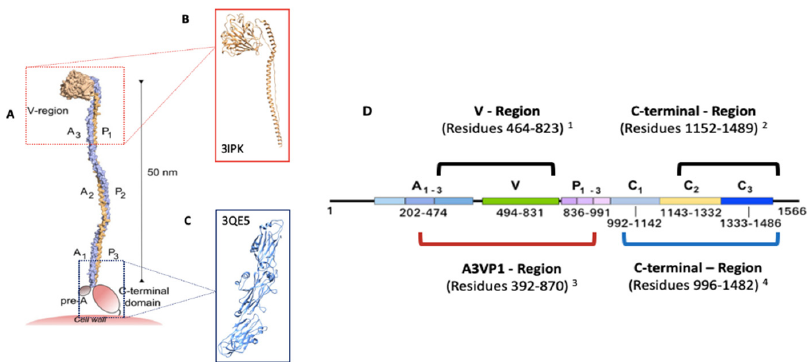
Figure 1. Crystals structures from the S. mutans Ag I/II protein ( A ). Model of S. mutans Ag I/II structure and predicted binding with human SAG (taken from [21]). ( B ) Crystal structure of A3VP1 protein from Ag I/II (3IPK) [21]. ( C ). Crystal structure C-domain protein from the Ag I/II (3QE5) [20]. ( D ). Schematic representation of the Ag I/II protein sequence (1566 aa) (Taken from [20]) and the description of the aa residues that constitute the crystals structures of the protein regions: 1—region V (PDB: 1JMM) [44]; 2—C-terminal domain [45]; 3—A3VP1 region (PDB: 3IPK) [21] and 4—the C-terminal region (PDB: 3QE5)